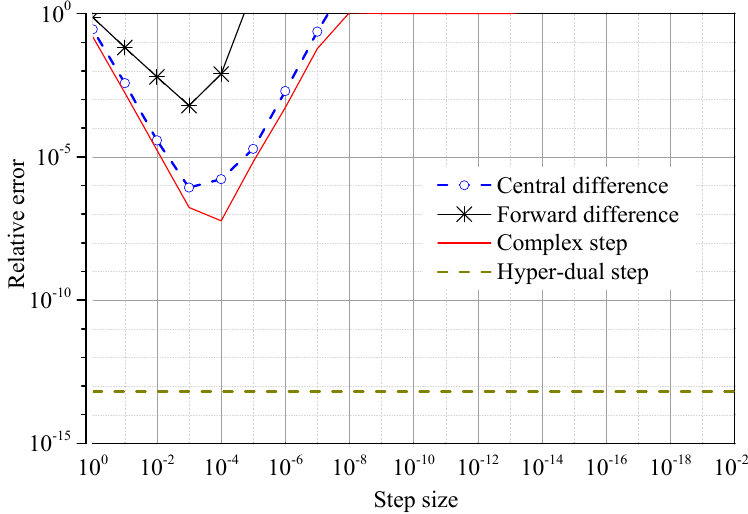
3213 qqq ∂∂∂∂ K —errors of nu-